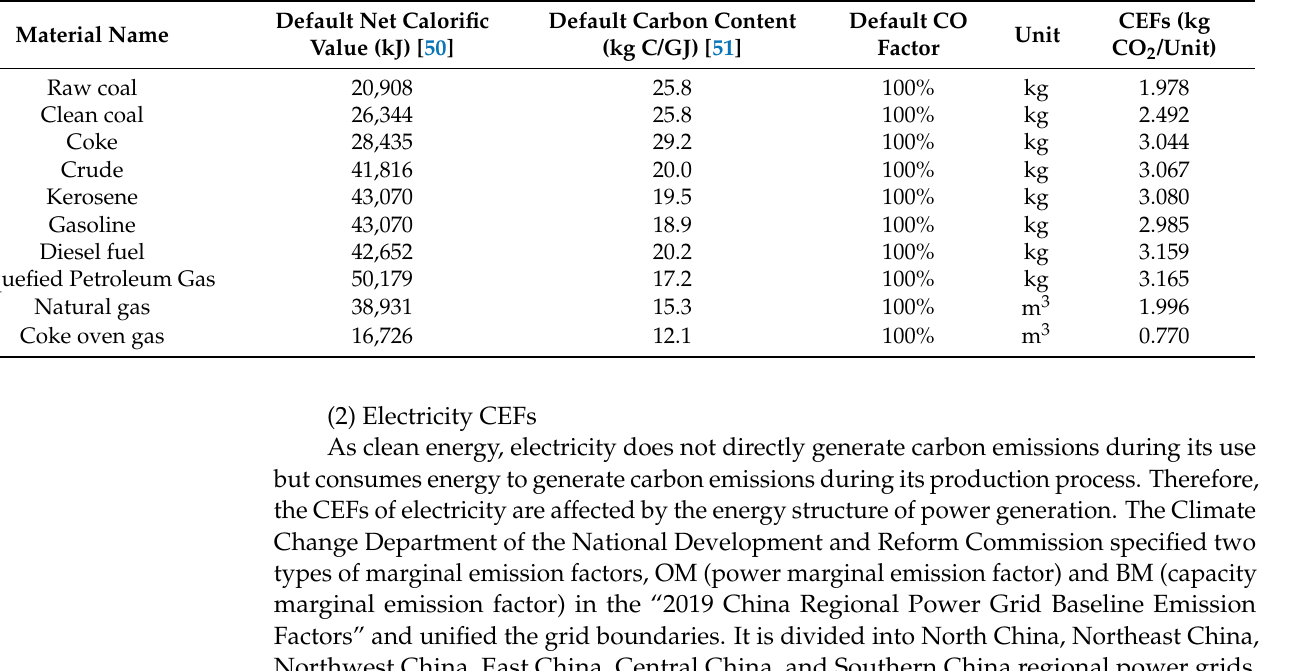
Table 4. Critical fossil energy